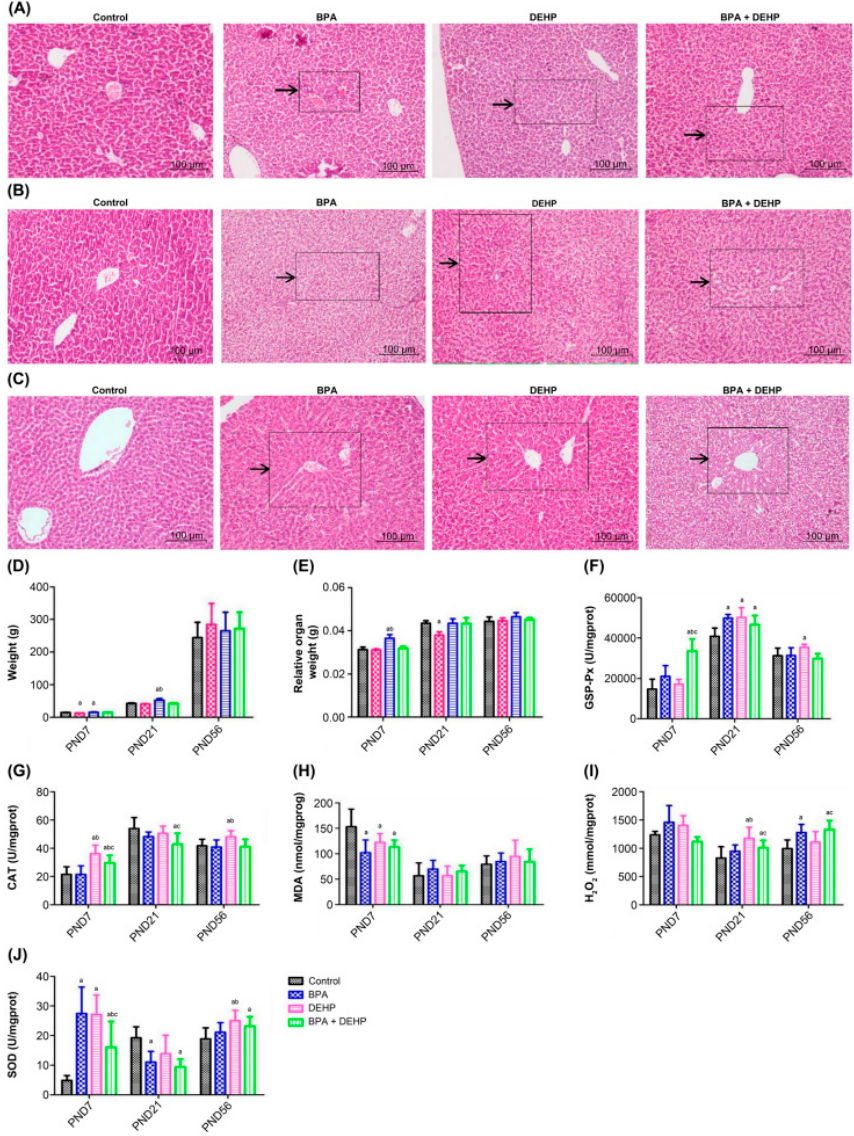
Figure 3. Histopathological changes of PND7, PND21 and PND56 of offspring with haematoxylin and eosin ( A – C ). Body weight gain of offspring exposed to BPA, DEHP and BPA+DEHP ( D ). Relative organ weight of offspring exposed to BPA, DEHP and BPA+DEHP ( E ). GSH-PX activity changes of offspring exposed to BPA, DEHP and BPA+DEHP ( F ). CAT activity changes of offspring exposed to BPA, DEHP and BPA+DEHP ( G ). H 2 O 2 assay of offspring exposed to BPA, DEHP and BPA+DEHP. ( H ). MDA activity changes of offspring exposed to BPA, DEHP, and BPA+DEHP. ( I ). Superoxide dismutase activity of offspring exposed to BPA, DEHP and BPA+DEHP ( J ). Data are presented as means ± SEM. [Note]: “a”: compared with control, “b”: compared with BPA group, “c”: compared with DEHP group, p < 0.05, n = 6. Scale bar = 1000 µ